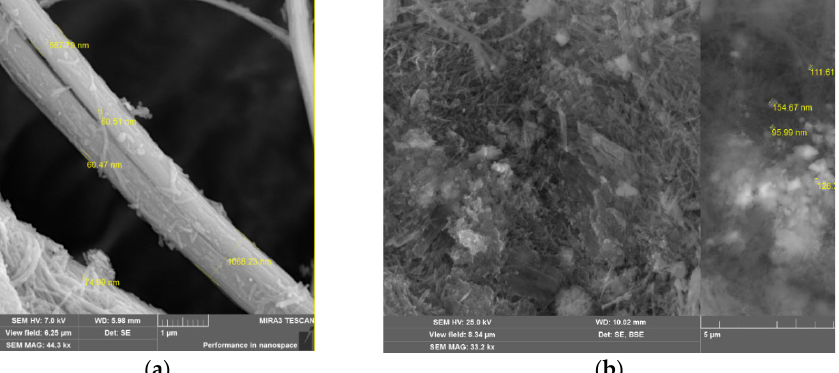
Figure 1. Microphotography of SEM of leached chrysotile and the NiCo/chrysotile nanocatalyst: ( a ) leached chrysotile; ( b ) NiCo/Chrysotile.